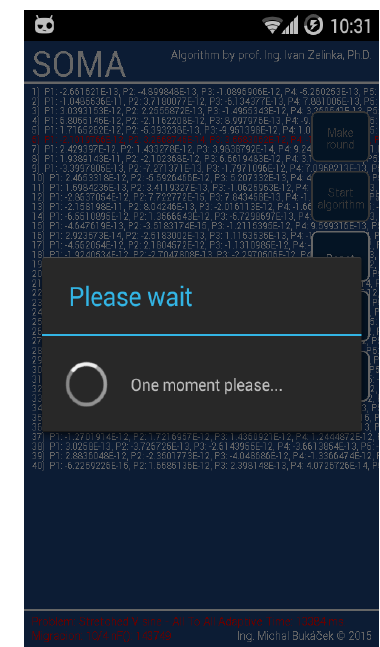
Fig. 5: Running migration round Source: Custom pro- cessing (cid:21) app